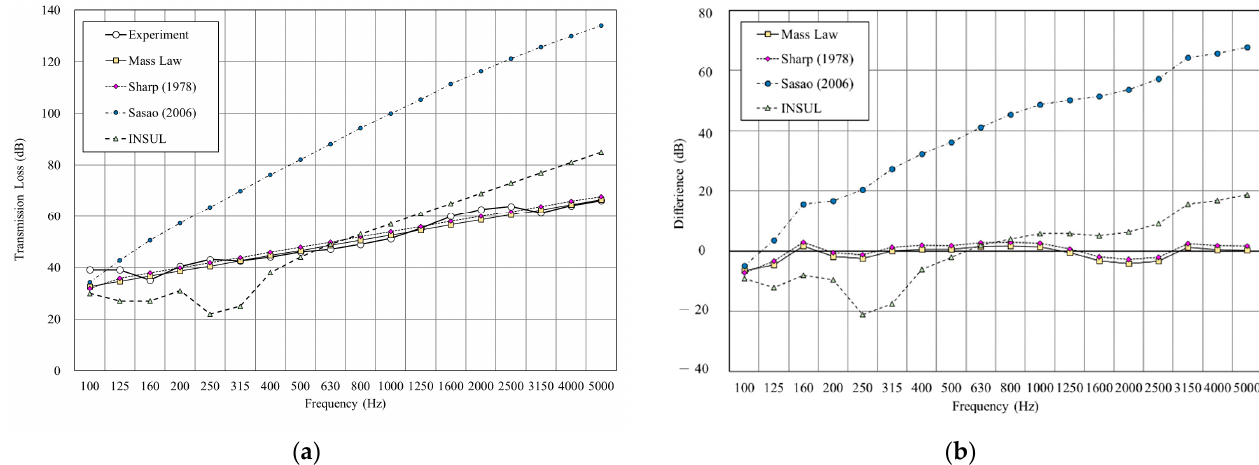
Figure 10. Comparison between experimental and predicted results of the double wall with 25 mm glass wool (B2). ( a ) The sound insulation performance of experiment and prediction. ( b ) The RMSE results of different prediction models.